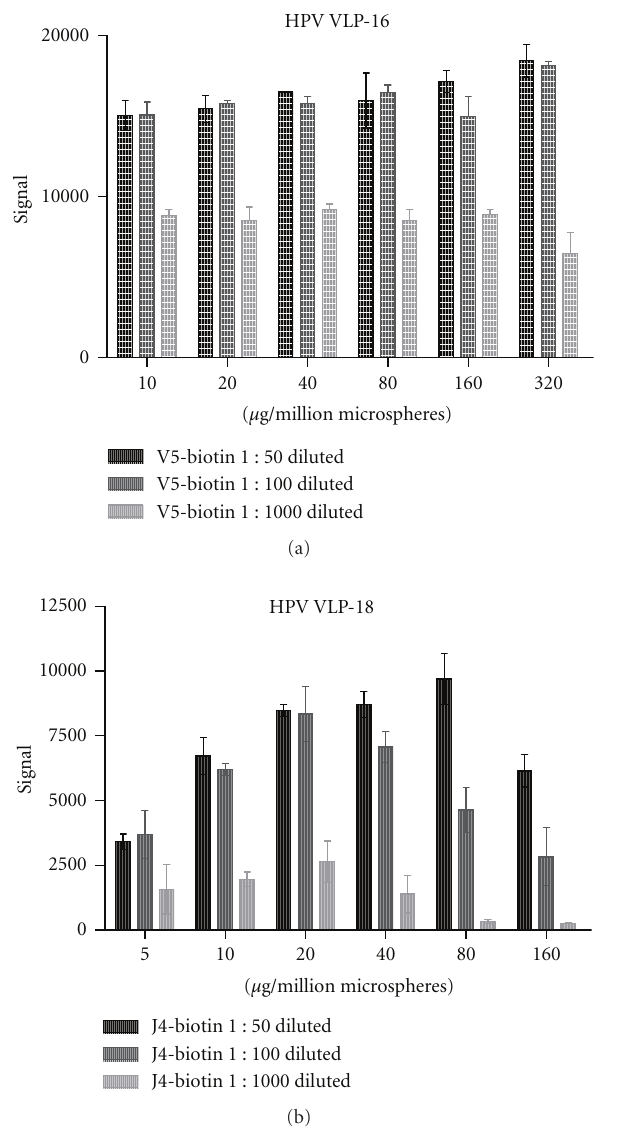
Figure 1: Coupling ratio optimization for HPV L1 VLPs and microspheres. (a) HPV-16 L1 VLP and #38 microspheres. (b) HPV- 18 L1 VLP and #53 microspheres.